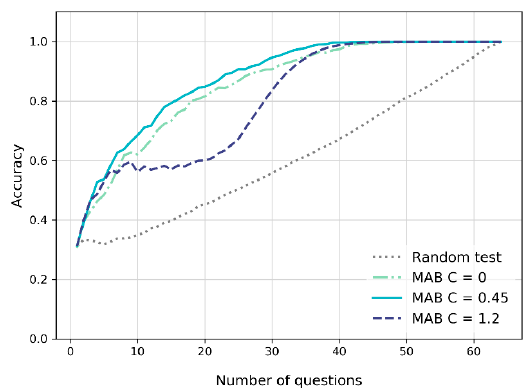
Figure 1. Assessment accuracy as function of number of questions in a quiz. A quiz contained a pool of 64 questions on 16 different topics and shows average accuracy for a class of 1000 synthetic students.